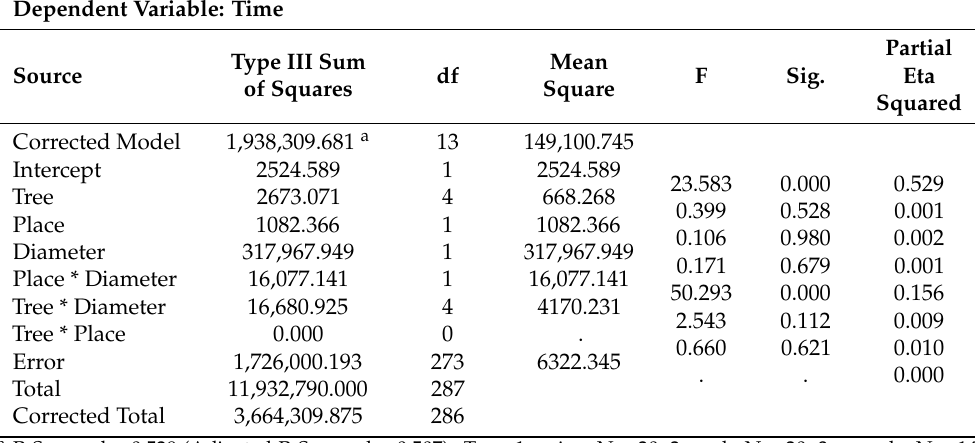
Table 7. Estimates and tests of effect size (tree, place, diameter, place/diameter, tree/diameter,